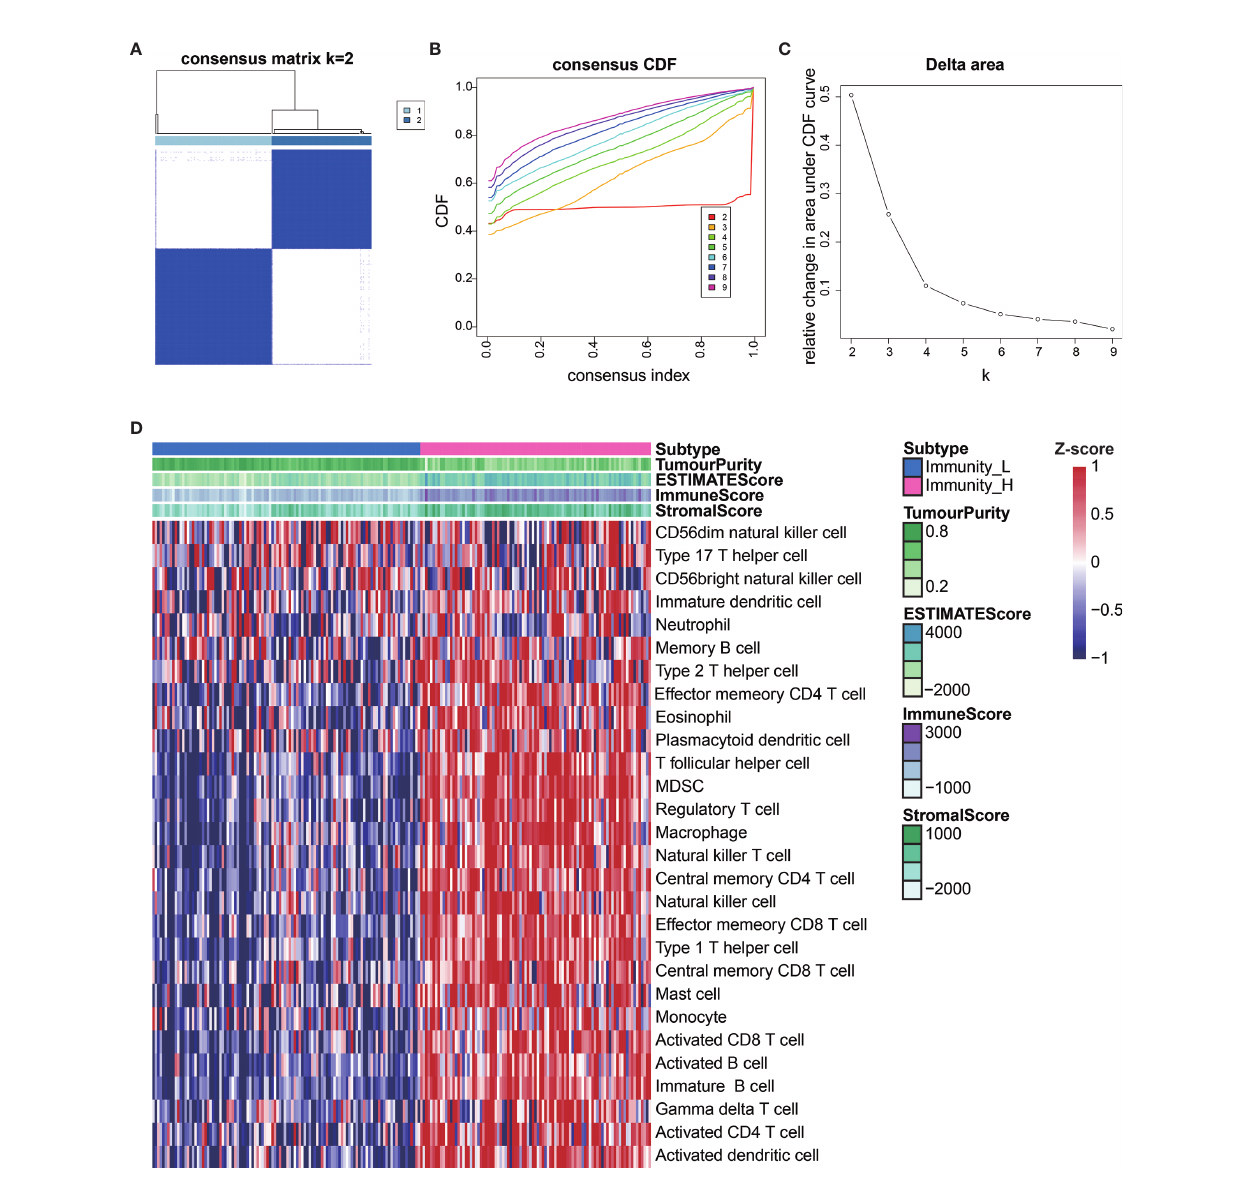
FIGURE 1 | Construction of AEG immune in fi ltration. Single-sample gene set enrichment analysis (ssGSEA) identi fi ed the relative in fi ltration of 28 immune cell type subpopulations with different immune in fi ltration subtypes. The relative in fi ltration of each cell type was normalized into a Z-score. (A – C) The optimal number of clusters (K=2) was determined from cumulative distribution function (CDF) curves, and the classi fi cation effect is the best. (D) Patients with a low level of immune cell in fi ltration were named as the low immune cell in fi ltration subtype (Immunity_L), and those with a high level of immune cell in fi ltration were named as the high immune cell in fi ltration subtype